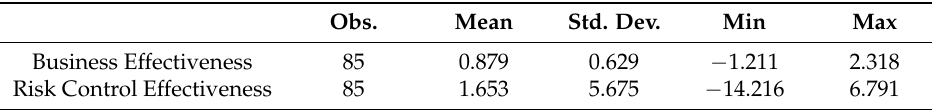
Table 4. Summary statistics of total insurers corporate governance effectiveness. Obs. Mean Std.